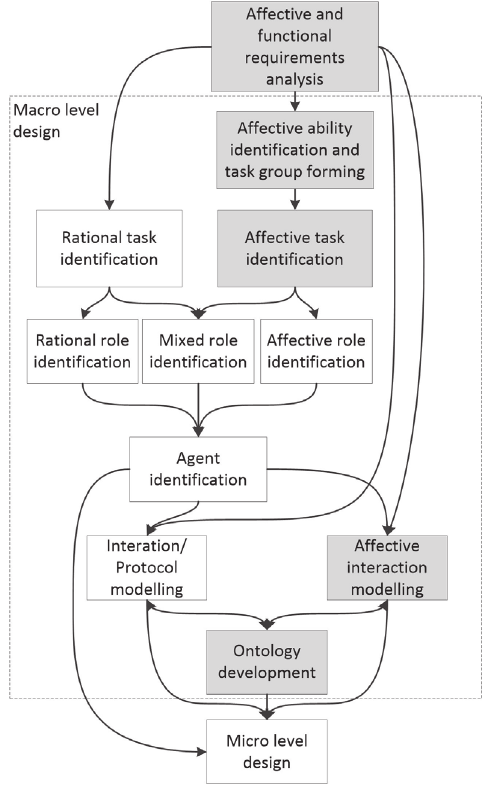
Fig. 1. Macro level design of affective